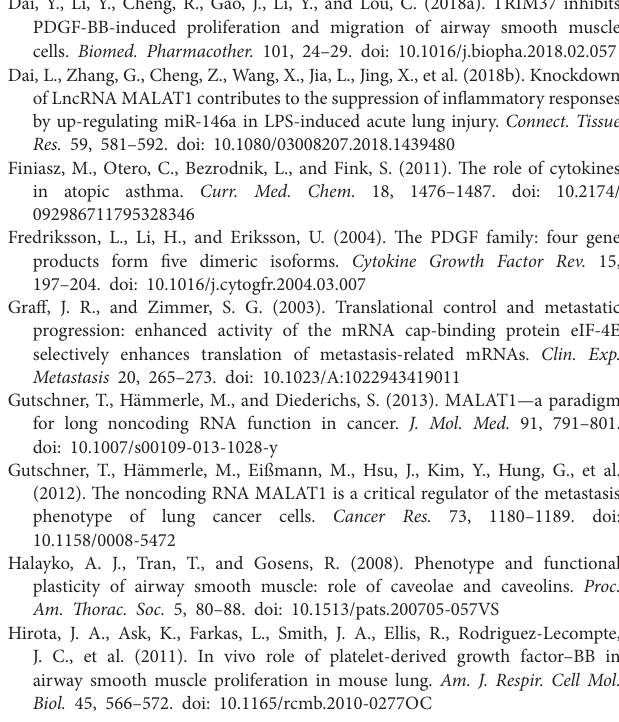
SUPPLEMENTARY FIGURE S1 | Identification of airway smooth muscle cells (ASMCs). (A) ASMCs are fusiform that grow at distinctive rates with peaks and valleys under an inverted phase contrast microscope (scale bar: 50 μ m). (B) Immunofluorescence staining shows positive expression of α -SMA (green) in ASMCs (scale bar: 20 μ